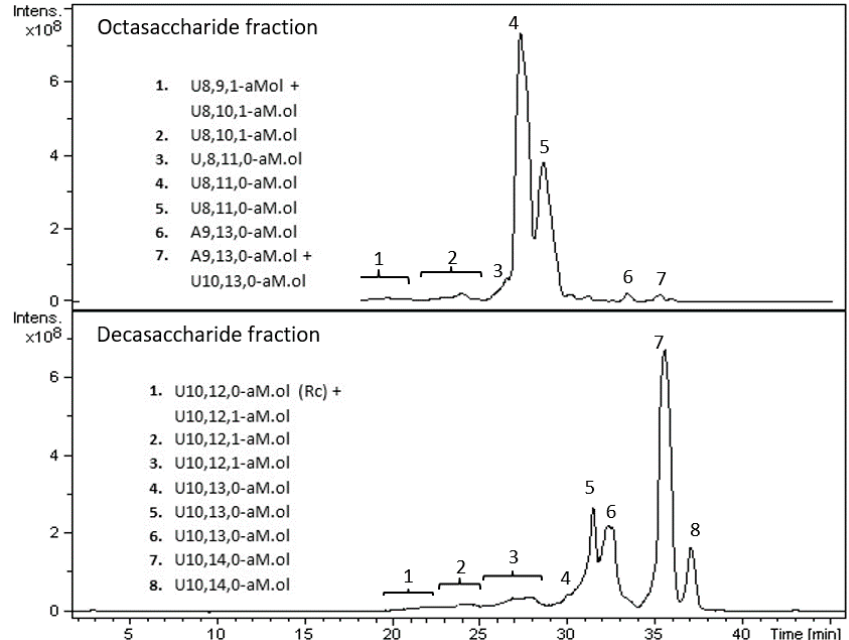
Figure 6. LC-MS profiles (BPC) of exemplary octasaccharide and decasaccharide fractions isolated from of Frag-5. Mass signals assignment of the main components is reported. LC elution conditions: linear gradients from 50% B to 57% B in 5 min and from 57% B to 80% B in 52 min, followed by column washing at 90% B and reconditioning in the initial conditions.